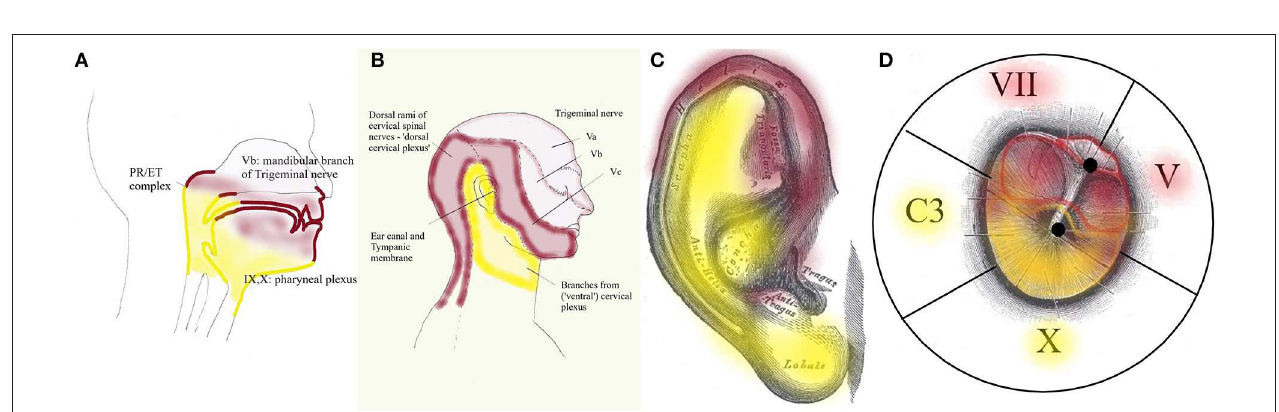
FIGURE 9 | TCC with dTCC and vTCC. Vpr Principal or Chief Trigeminal nucleus. Vmes Mesencephalic Trigeminal nucleus. Vsp Spinal Trigeminal nucleus. Vmot Motor Trigeminal nucleus. Sol Solitary nucleus Amb nucleus Ambiguous. sAcc Spinal Accessory nucleus. Dark blue arrows: afferent, dorsal system, Light blue arrows: afferent, ventral system (proprioceptive, exteroceptive); red arrows: efferent dorsal system, yellow arrows: efferent ventral system (motor). Dotted arrows indicate unproven pathways. Vpr and Vmes have not been duplicated in vTCC.